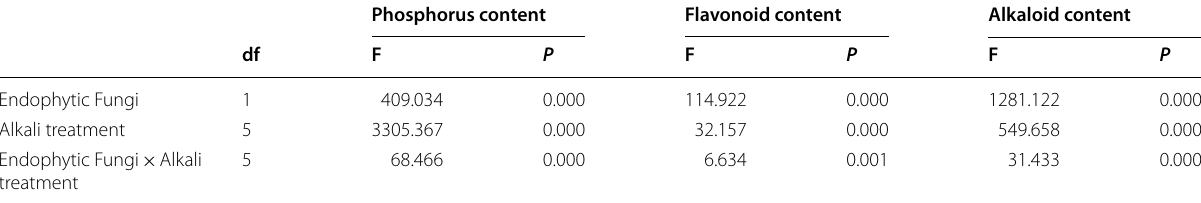
Table 1 Two-factor analysis of endophytic fungi on the phosphorus content, flavonoids, and alkaloids of Hordeum bogdanii under alkali